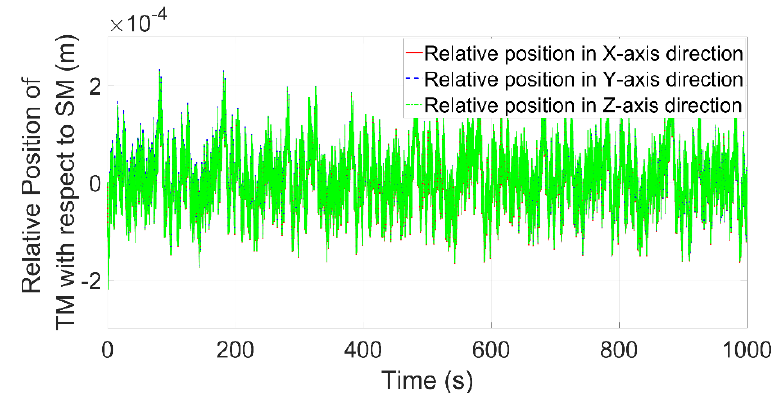
Figure 7. Centroid position of the TM with respect to the SM. TM, test mass.